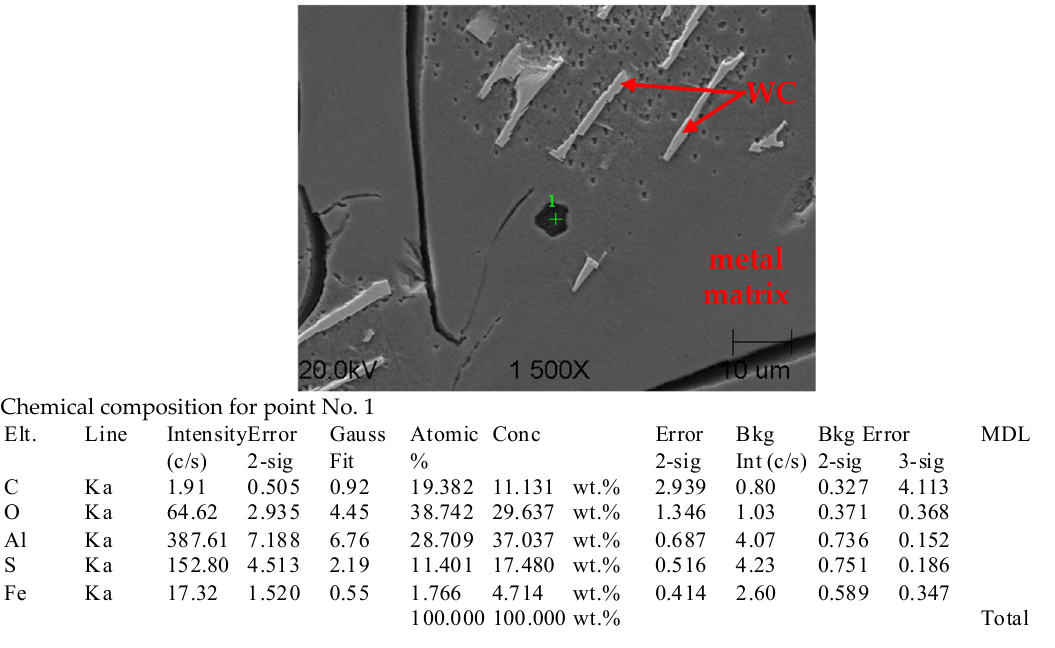
Figure 11. SEM microstructure of high-aluminum cast iron with the addition of tungsten with a chemical composition analysis for no. 1 oxide particle.